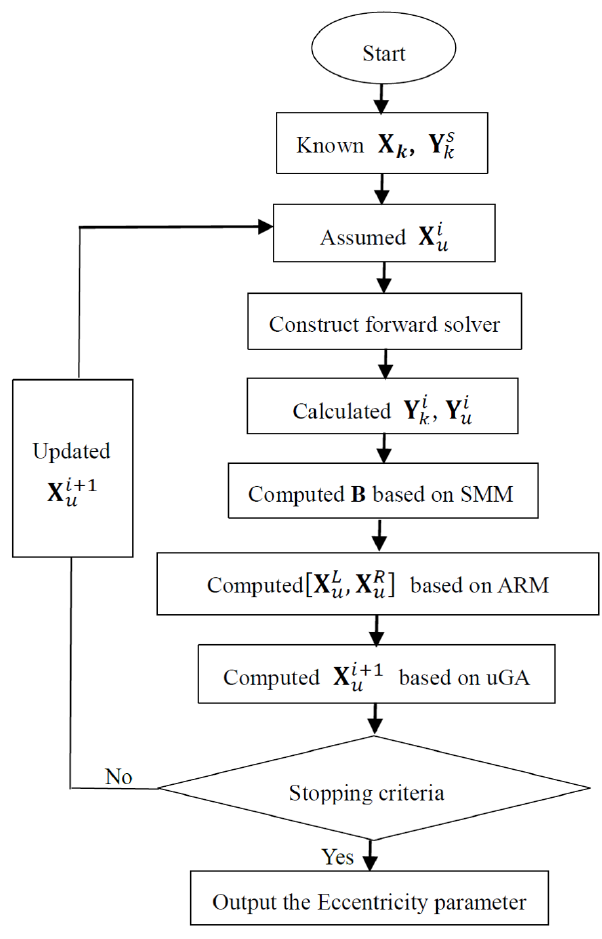
Figure 3. Identification flow